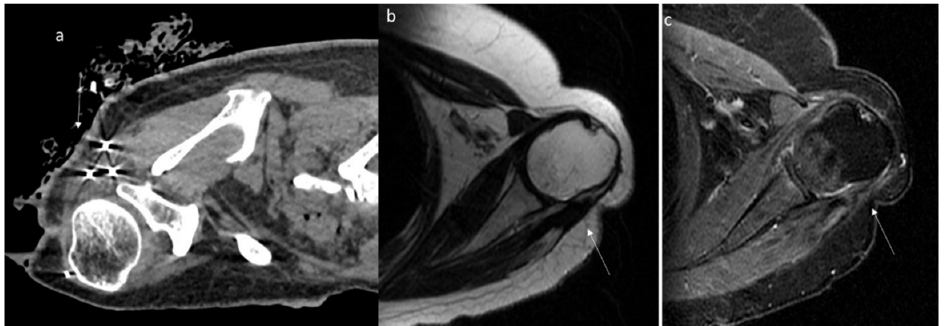
Figure 5. The same patient of Figure 4, treated by CT-guided cryoablation (probes and ice-ball within the lesion in ( a ); the follow-up control after 6 months depicts evident volumetric and enhancement reduction of the lesion ( b , c ).